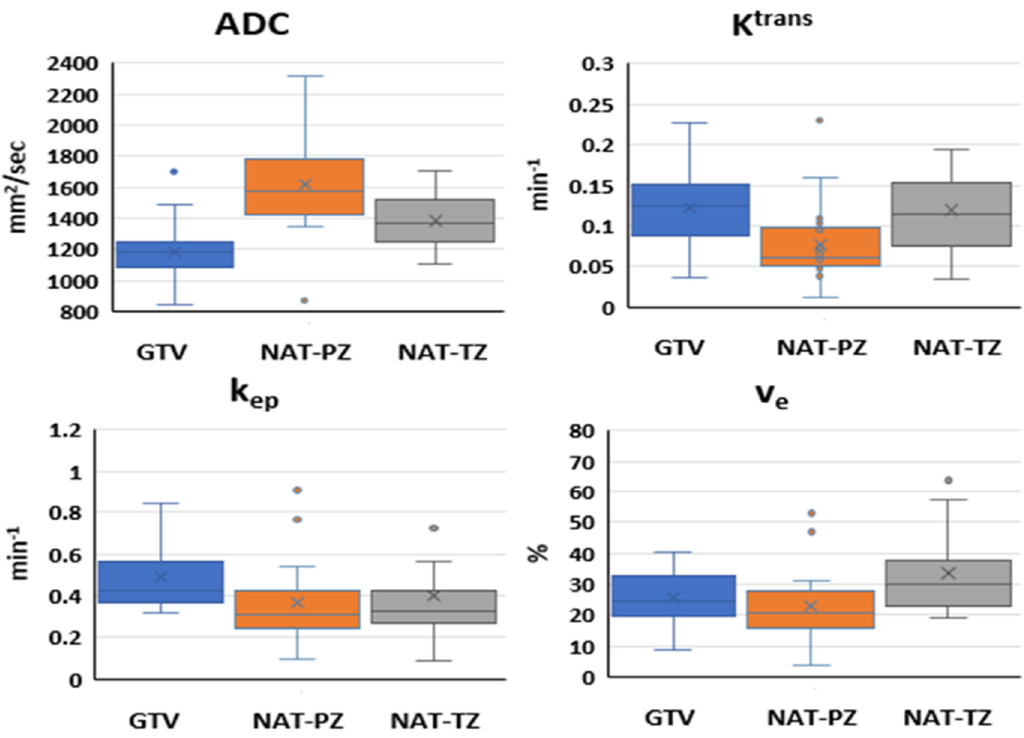
Figure 4. Quantitative imaging features in analyzed ROIs at baseline: Box and whisker plots comparing ADC, K trans , k ep , and v e in GTV, NAT-PZ, and NAT-TZ. ADC values were significantly different between the three ROIs. K trans in NAT-PZ was significantly lower than in the other two ROIs. k ep in GTV was significantly higher than in the other two ROIs. v e in NAT-TZ was significantly higher than in other two ROIs ( p = 0.001). Table 3. Quantitative imaging features extracted from longitudinal mpMRI exams before and following LEAD